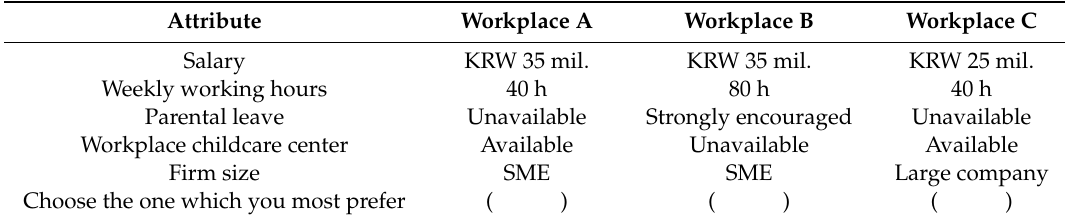
Table 2. A sample choice set.